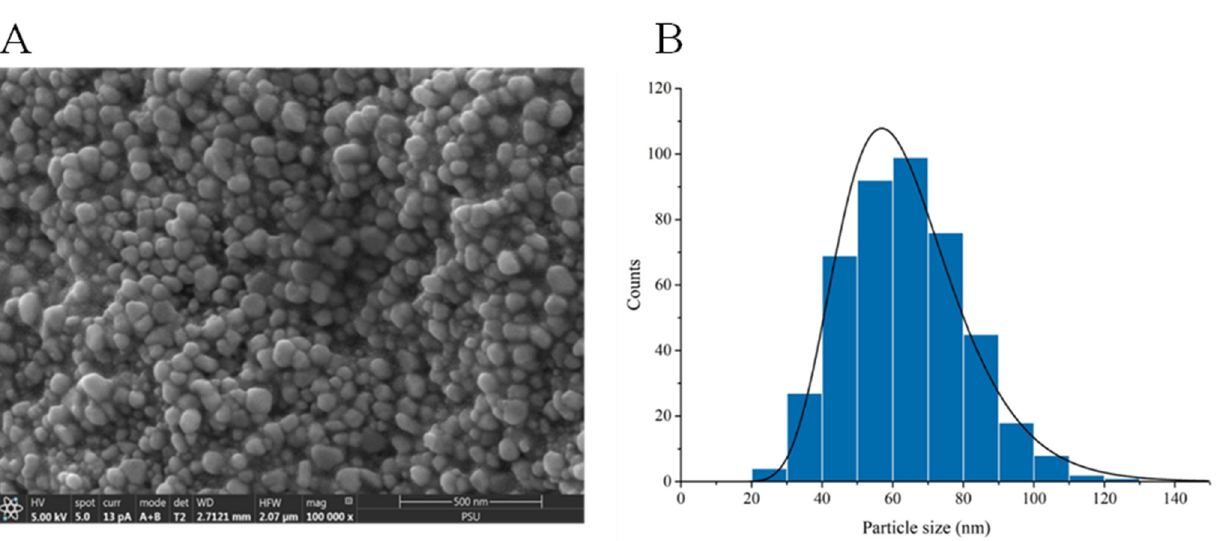
Figure 3. ( A ) Representative scanning electron microscopy image of AgNPs-coated urinary catheters and ( B ) particle size distribution of AgNPs on the coated surface.